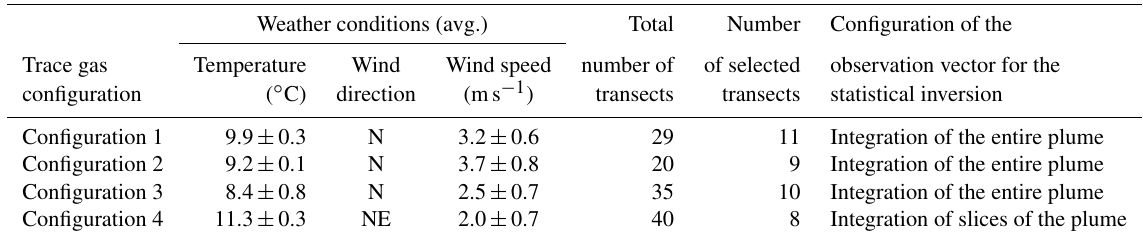
Table 1. Weather conditions during the four tests and configuration of the observation vector for the statistical inversion. Weather conditions (avg.) Total Number Configuration of the Trace gas Temperature Wind Wind speed number of of selected observation vector for the configuration ( ◦ C) direction (ms − 1 ) transects transects statistical inversion Configuration 1 9.9 ± 0.3 3.2 ± 0.6 29 11 Integration of the entire plume Configuration 2 20 9 Integration of the entire plume Configuration 3 35 10 Integration of the entire plume 40 8 Integration of slices of the